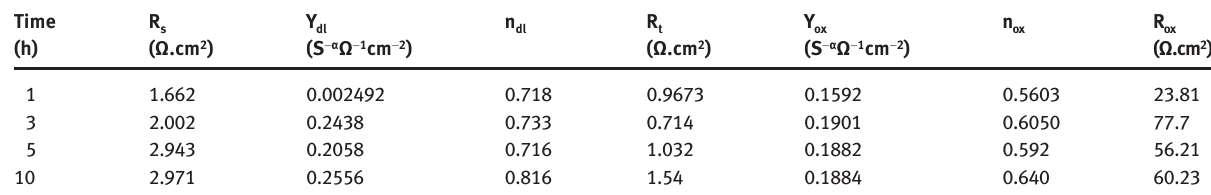
Table 1: Fitting results of the impedance spectra for porous Cu-35mass%Ni-5mass%Cr in molten (0.62Li,0.38K) 2 CO 3 at 650 °C in air Time